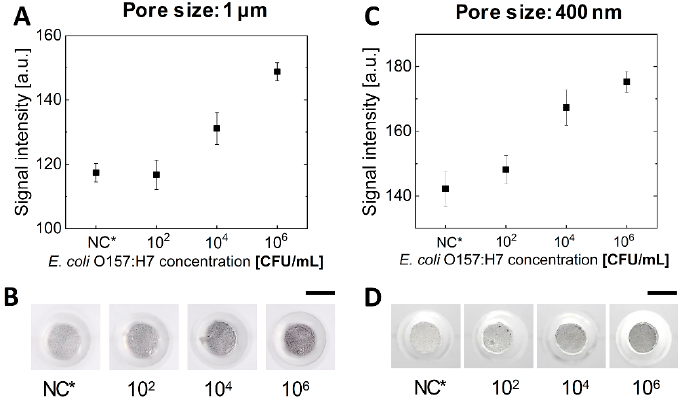
Figure 4. Colorimetric detection results of E. coli O157:H7 on a finger-powered microfluidic device when the filter membrane with different pore sizes was used. (A,B) 1 μ m. (C,D) 400 nm. NC* indicates when the filter membrane with di ff erent pore sizes was used. ( A , B ) 1 µ m. ( C , D ) 400 nm. NC* indicates negative control. Scale bars = 3 mm. negative control. Scale bars = 3